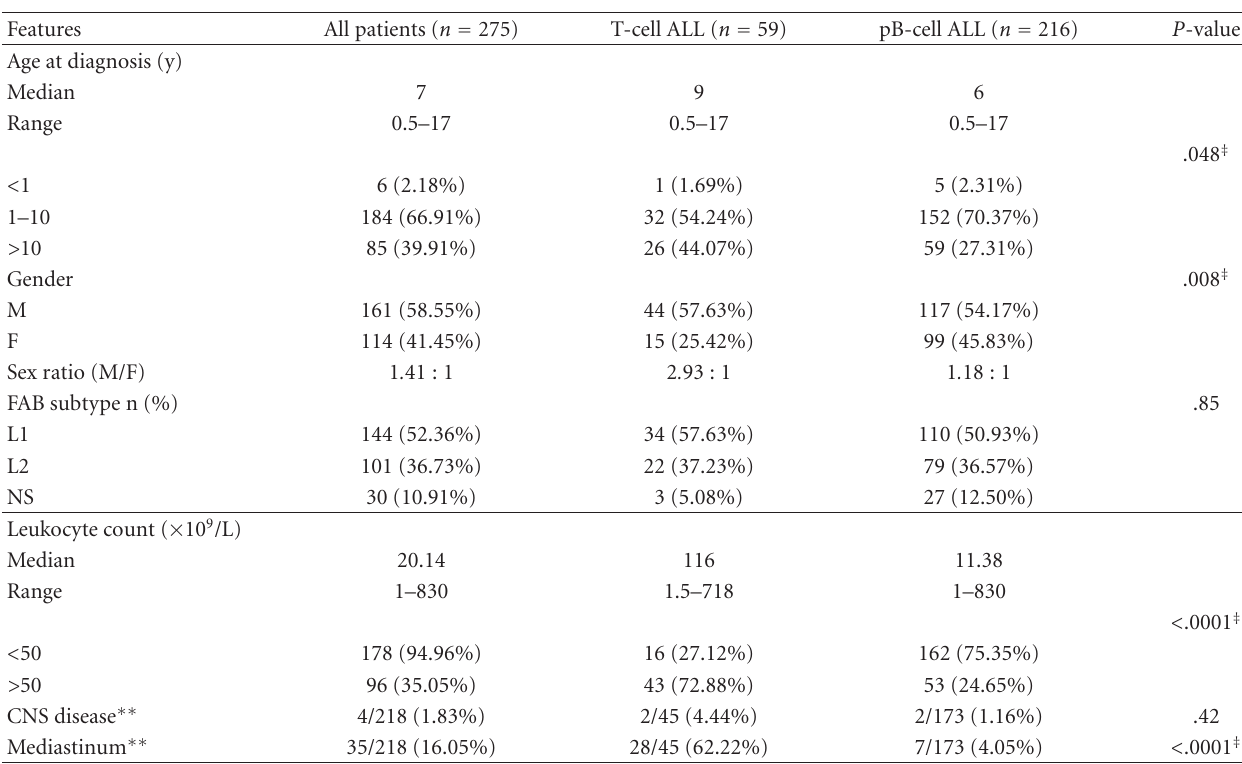
Table 2: Patients’